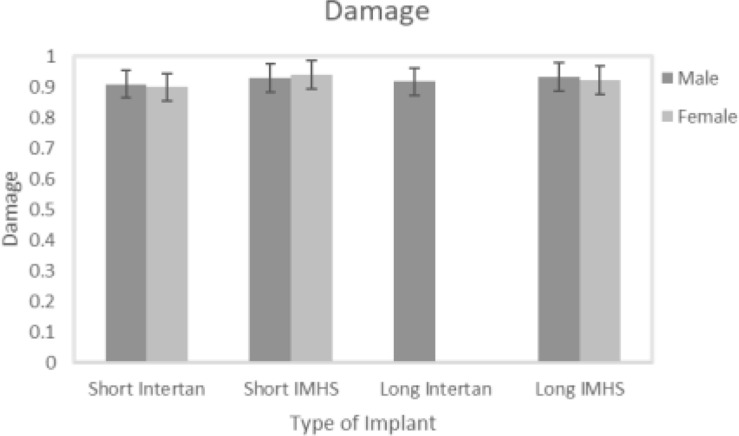
Damage versus gender.